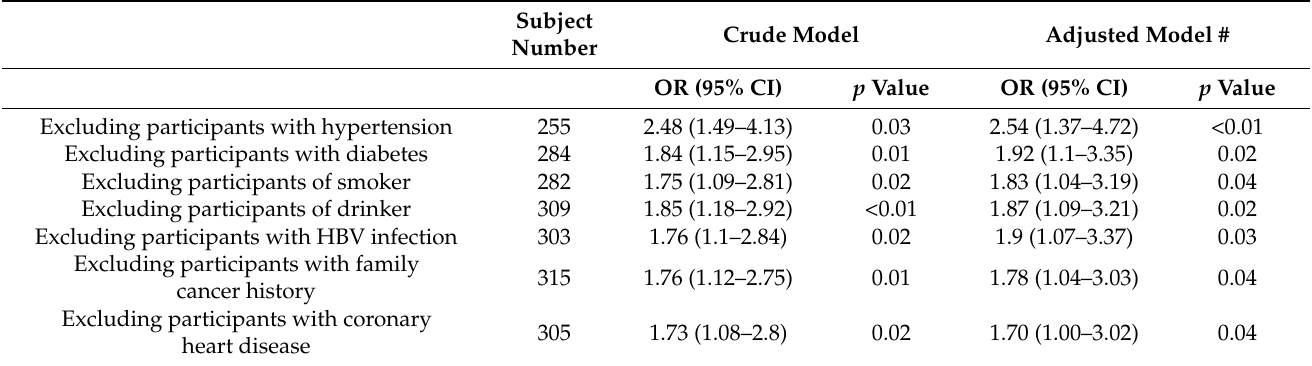
Table 2. Sensitivity analyses on the association of HEV exposure and cancer risk in patients with gastric cancer.